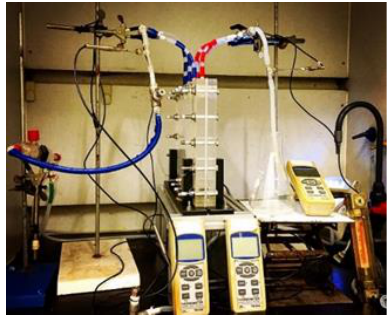
Figure 6. A photo of a real experimental setup.